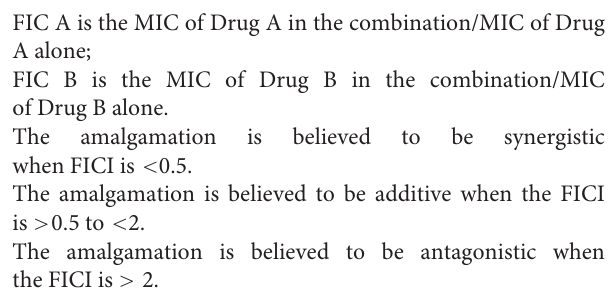
TABLE 1 | Phytochemicals of A. philippense crude extract. Phytochemicals Crude extract Alkaloids + Flavonoids + Terpenoids